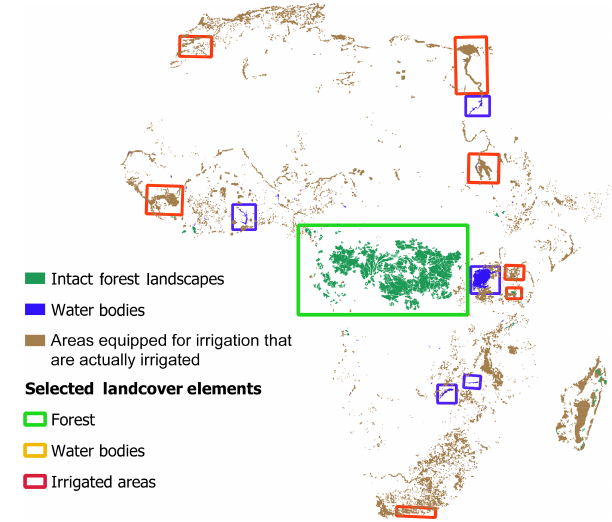
Figure 4. IFL, WB GRanD and AEIai land cover element maps and areas selected for visual